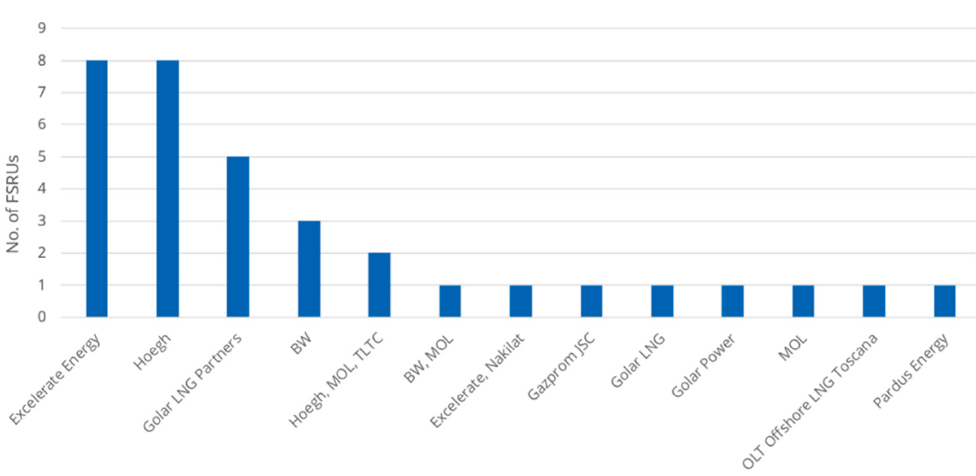
Figure 1. Active number of floating storage and regasification units (FSRUs) by owner [1].